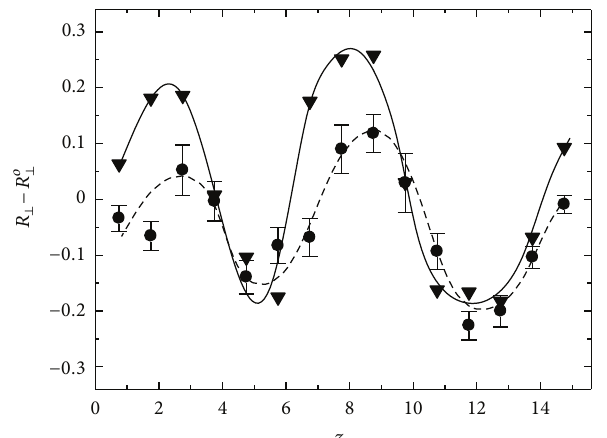
Figure 14: Δ𝑅 ⊥ ≡ 𝑅 ⊥ − 𝑅 0 ⊥ [𝜎] for the chains ( 𝑁 𝑝 = 10 ) with functional end beads for ( ∙ ) 𝜀 𝑝 𝑏 = 𝜀 𝑝 𝑤 = 𝜀 and ( 󳶃 ) 𝜀 𝑝 𝑏 = 𝜀 𝑝 𝑤 = 2𝜀 . ( 𝑧[𝜎] is the distance from the wall.) Error bars indicate one-half of the standard deviation and are shown only for 𝜀 𝑝 𝑏 = 𝜀 𝑝 𝑤 = 𝜀 .